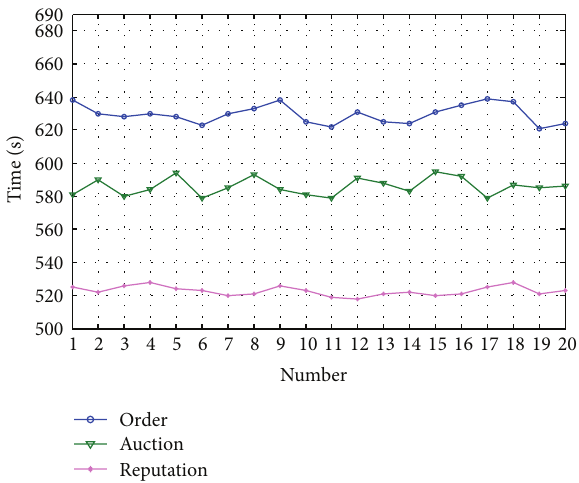
Figure 10: Comparison of small number of arranged tasks.